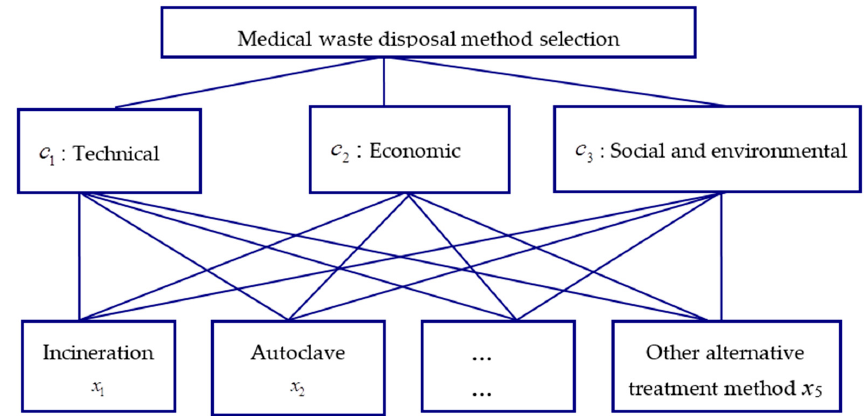
Figure 1. Decision hierarchy of a medical waste disposal method selection problem.